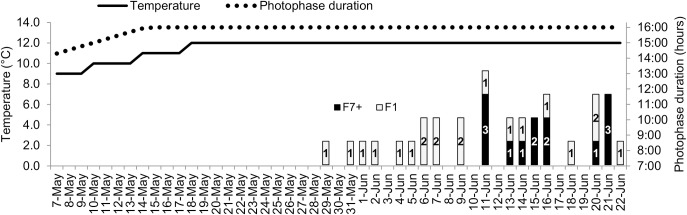
Timetable of the spawn obtained for both populations during the spawning season in relation to temperature and photophase increase at the end of the photothermal program.Bars with numbers correspond to the number of spawn obtained each day for F1 and F7+ females.